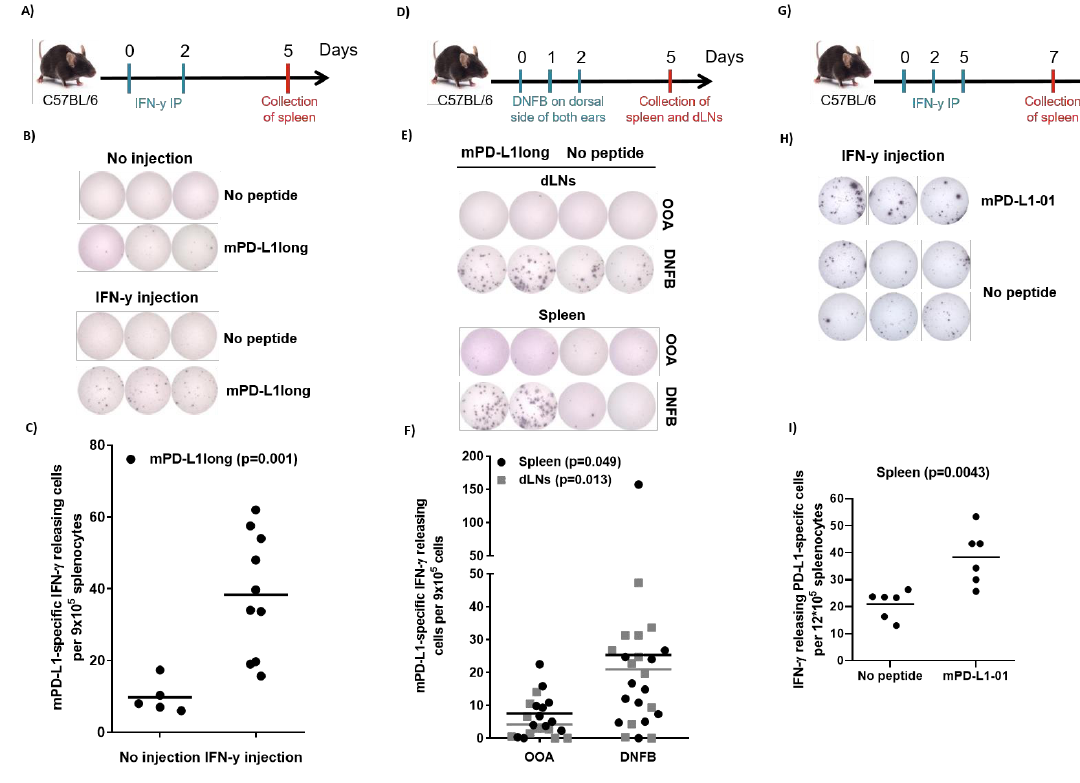
FIGURE 3 : Inflammation-induced PD-L1-specific T cells in vivo . (A) Experimental timeline: C56BL/6 mice were injected twice with 1 µg IFN- y in 200 µl PBS IP (or no injections as a control) on day 0 and day 2. On day 6 the mice were sacrificed, and spleens were analyzed for PD-L1 reactivity. (B) Examples of IFN-y-ELISPOT experiments with splenocytes from a control mouse ( top ) or an IFN-y-injected mouse ( bottom